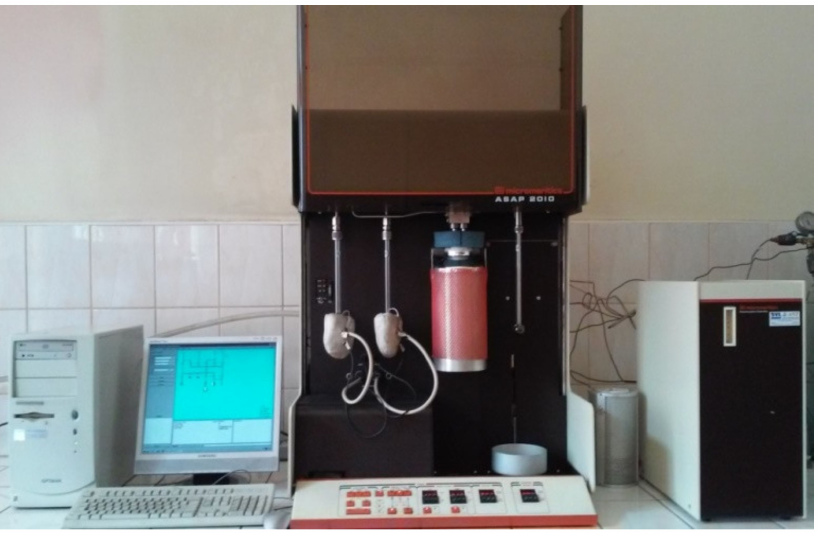
Figure 6. ASAP 2010 volumetric sorption